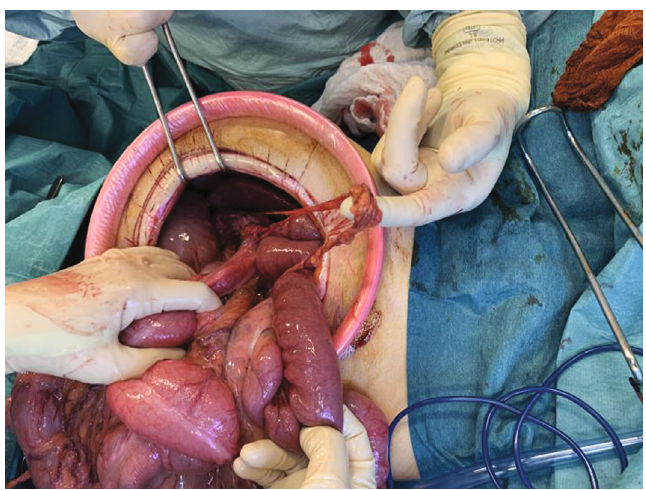
Figure 5: Bridle causing the volvulus of the small intestine.